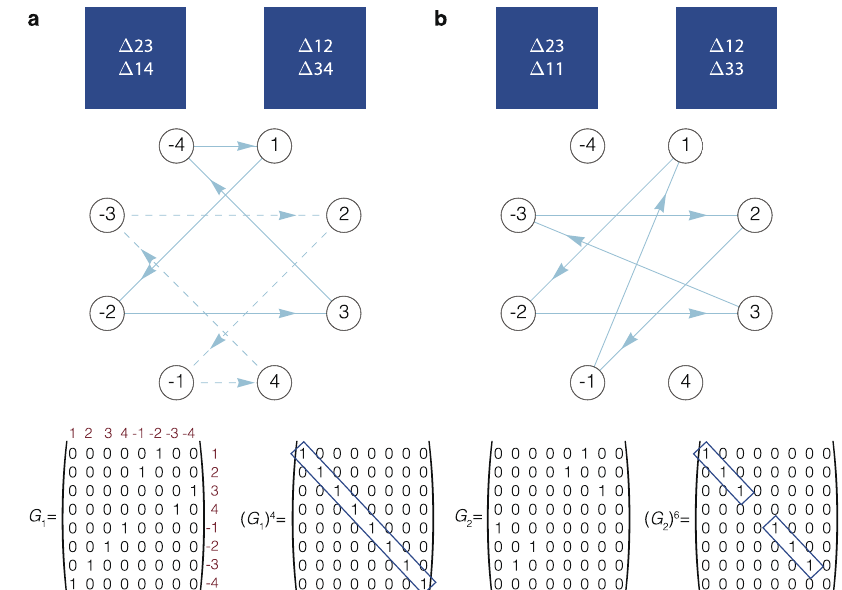
Fig. 7 | The directed graph representation to analyze mode-independent resonances in cascaded-mode resonators. a Top: a cascaded-mode resonator that couples four modes, where each mode appears only once in the resonance ( N =4, ξ =1).Middle:thecorrespondinggraphoftheresonatorcontainstwocycles. Thetwocycles(solidlines,dashedlines)existbecauseofthesymmetryofthemode converters: if the edge i → − j exists, then the edge j → − i also exists. Bottom: The adjacencymatrix of the graph( G 1 ) and theadjacencymatrix raised to the power 4, ð G Þ 4 . The adjacency matrix raised to the power N is a diagonal matrix, illustrating 1